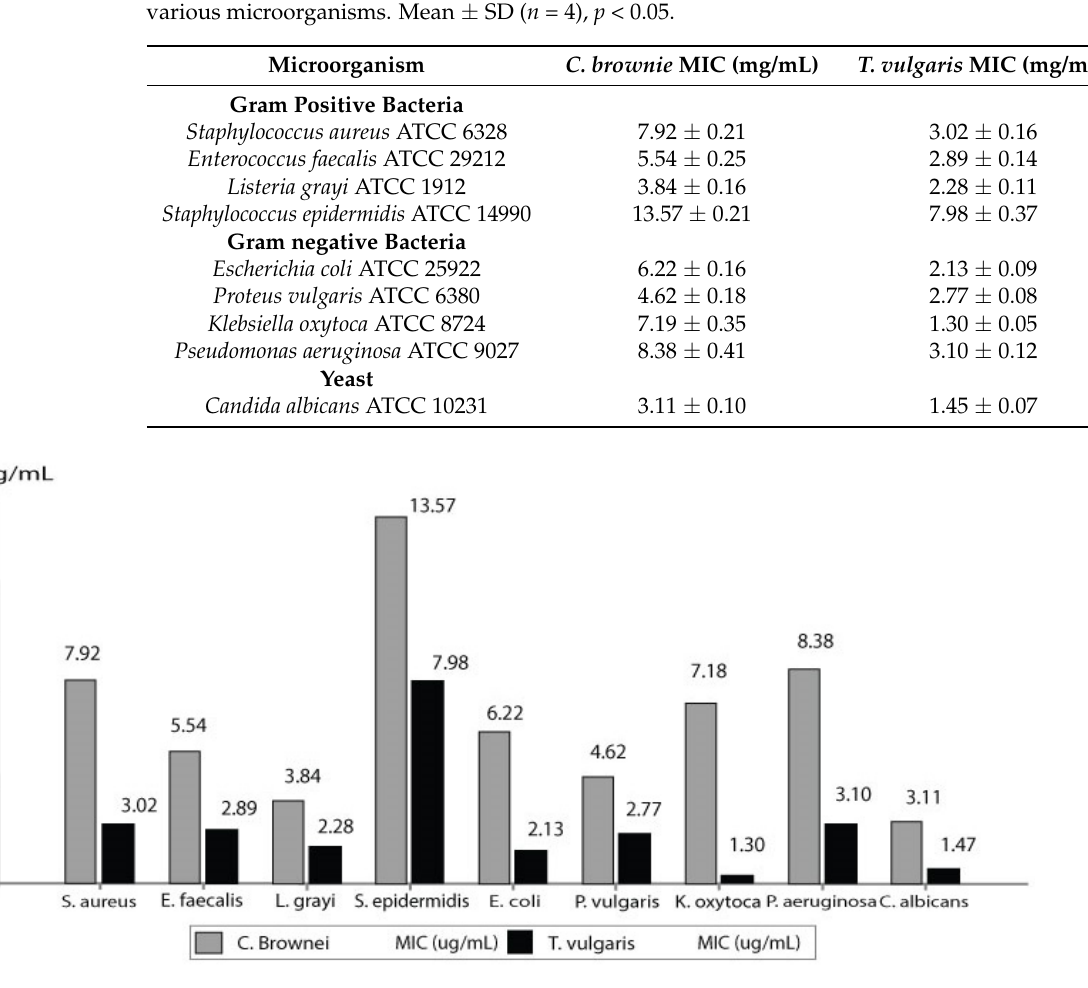
Figure 2. Graphical comparison of minimum inhibitory concentration (MIC) values between the essential oils of C. brownei and T. vulgaris (natural control). Mean ± SD ( n = 3), p < 0.05.